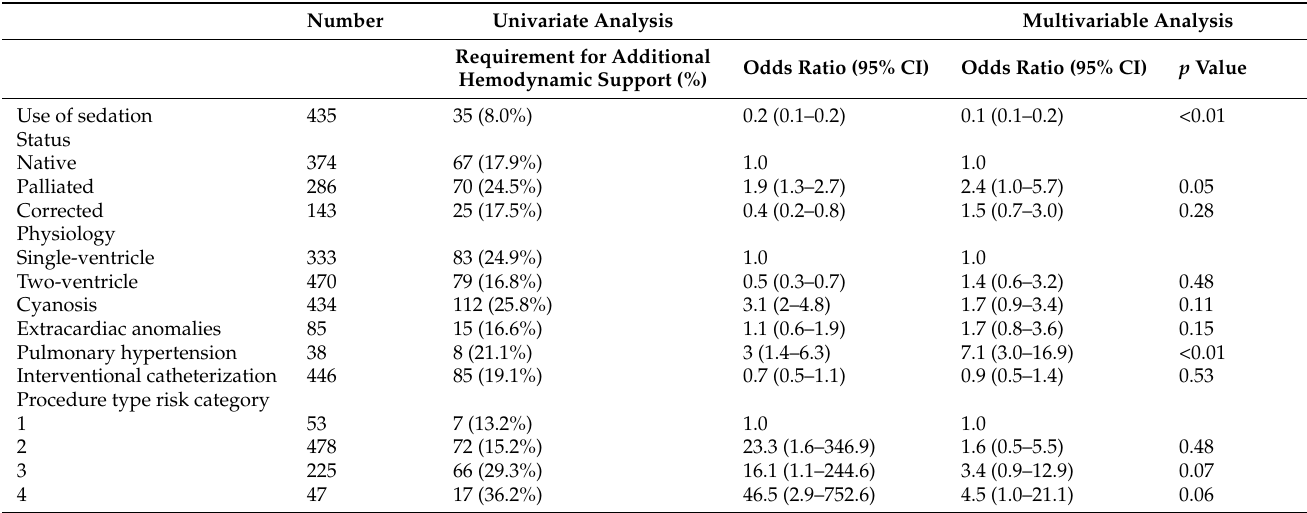
Table 7. Predictors of requirement for additional hemodynamic support and multivariable analysis. Univariate Analysis Multivariable